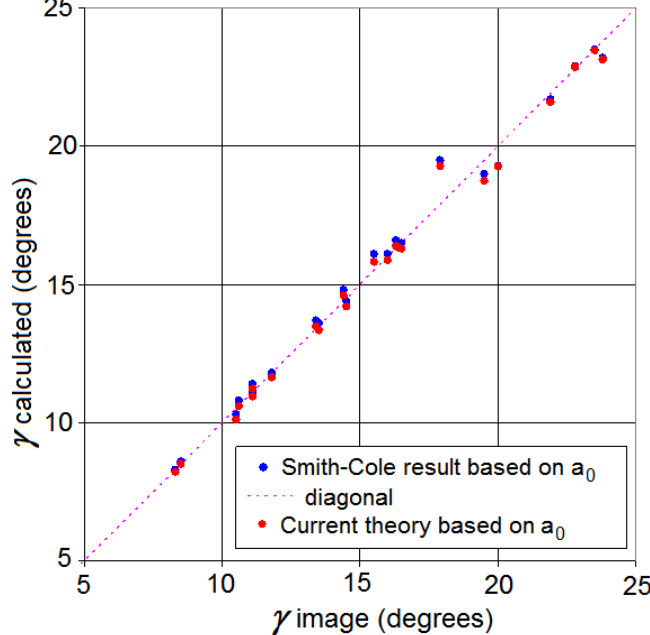
Figure 9. Comparison of the measured image angle and calculated angle from the Cole-Smith theory (Appendix B) and Equation (60).